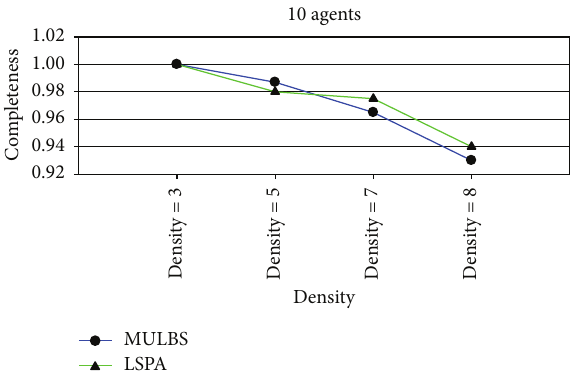
Figure 3: Run time of MUBLS and LSPA in the first phase.